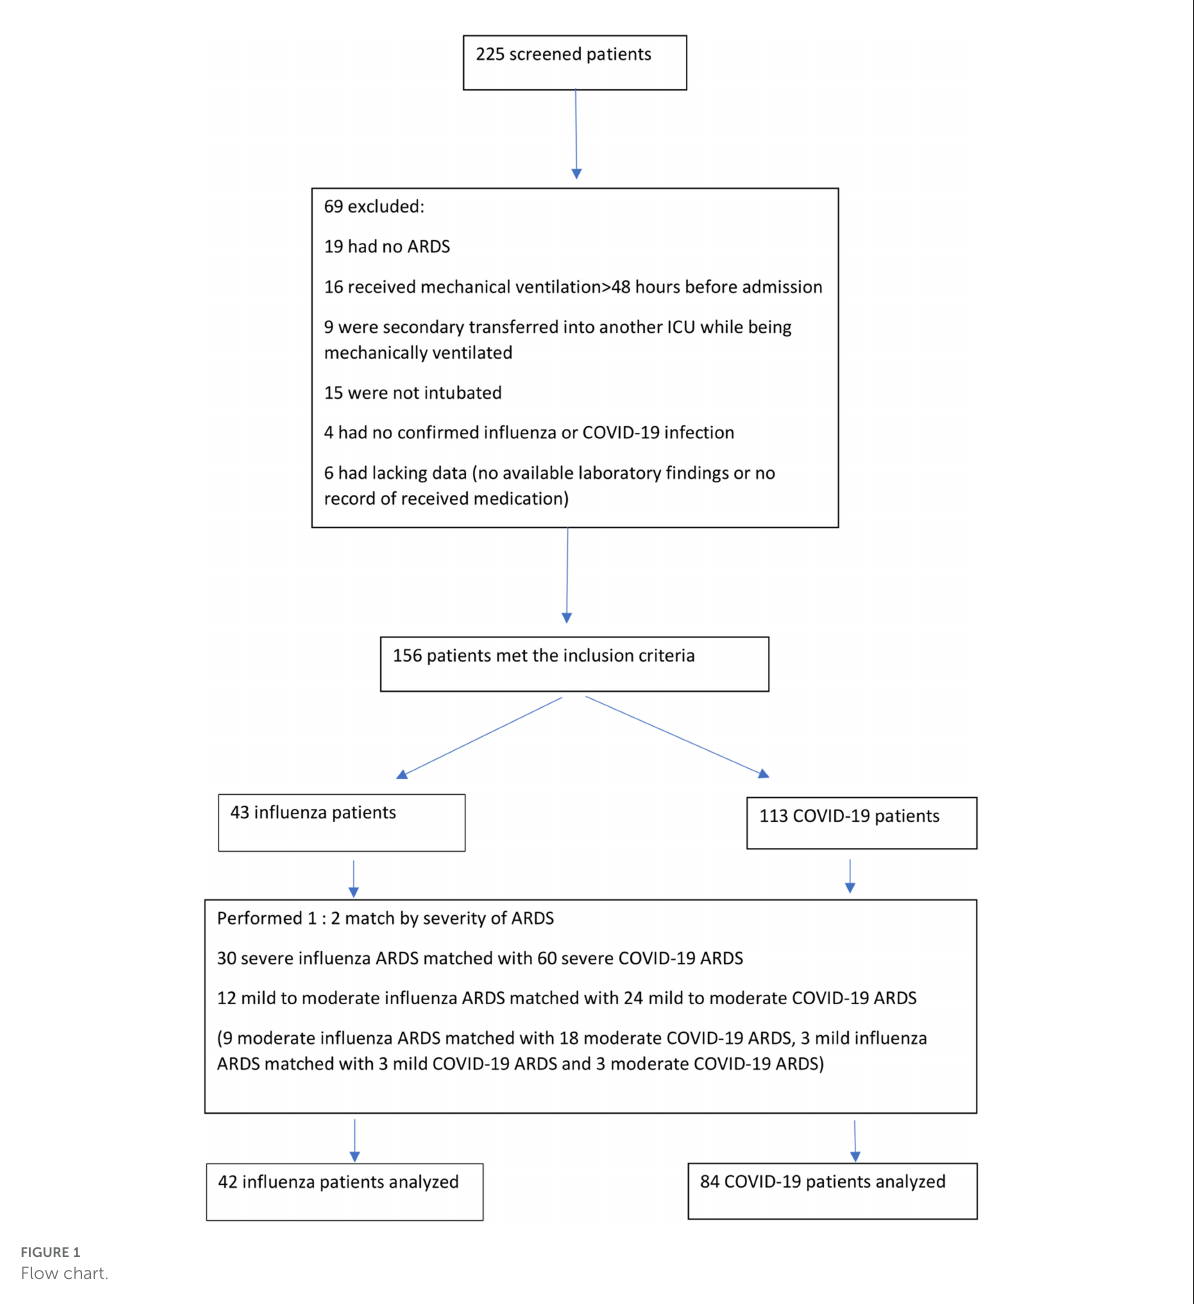
corticosteroids, neuromuscular blockers, and duration